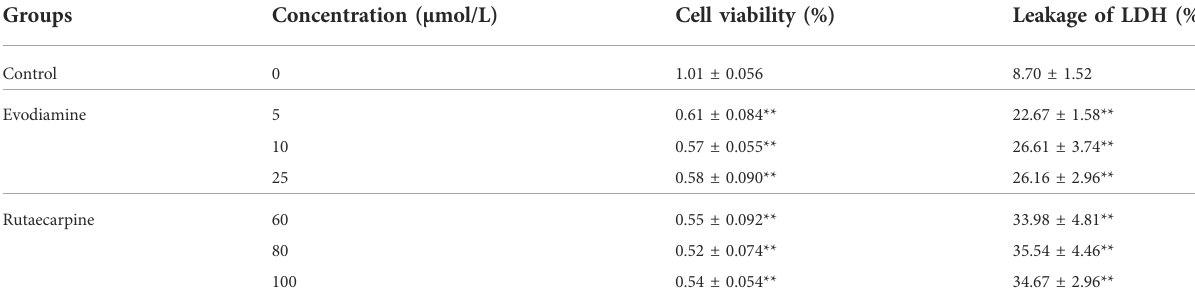
TABLE 5 Cardiotoxicity induced by evodiamine and rutaecarpine in NRCMs ( n = 6, ‾ x ± s ).